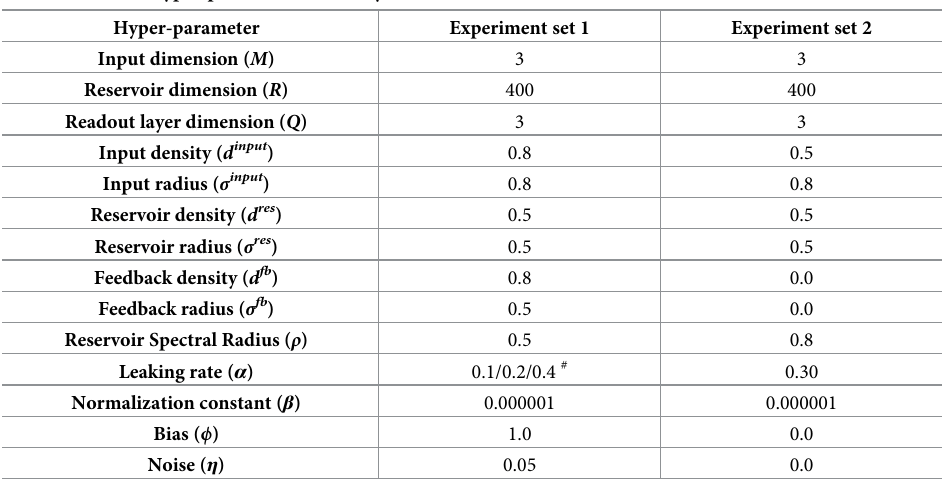
Table 2. Network hyper-parameters summary.